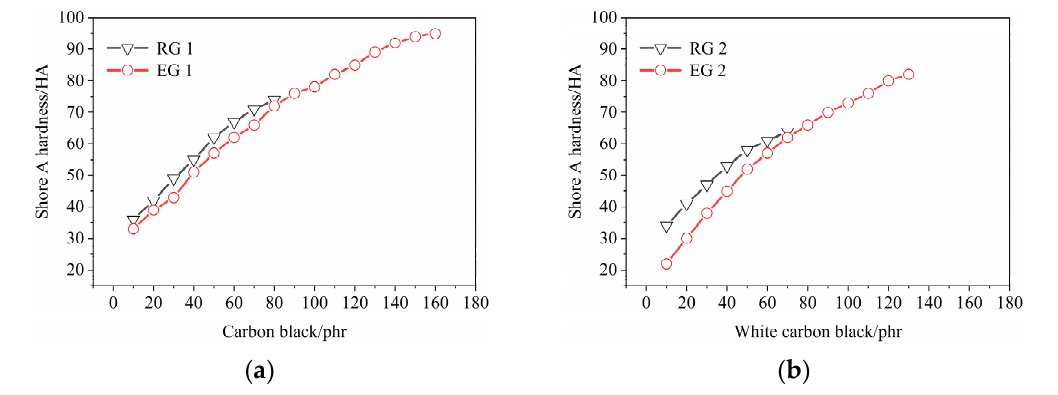
Figure 4. Effect of filler on the Shore A hardness of rubber samples. RG 1 and EG 1 were for SBR rubber mixtures; RG 2 and EG 2 were rubber mixtures based on NR rubber. ( a ) Effect of CB on the Shore A hardness of rubber samples; ( b ) Effect of WCB on the Shore A hardness of rubber samples.